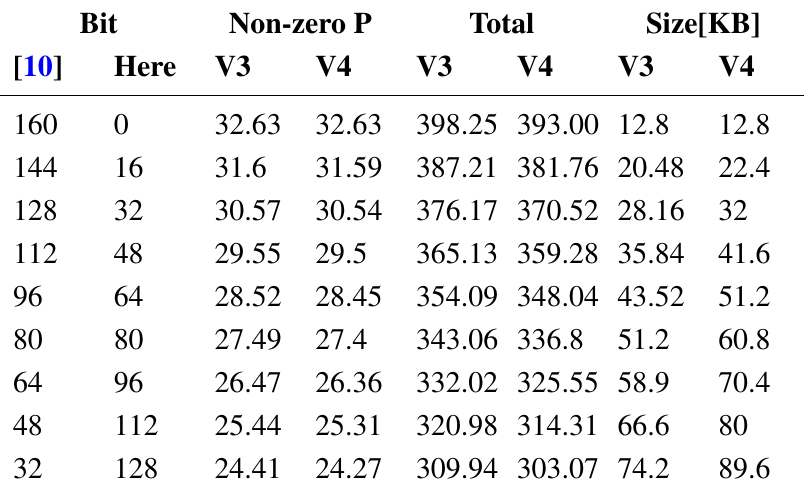
Table 10. Performance evaluation for the hybrid model in the case of 4NAF. V3 and V4 denote version 3 and 4, respectively. The bit section indicates the ratio of bits using our method and that of [10], respectively. Non-zero P: non-zero